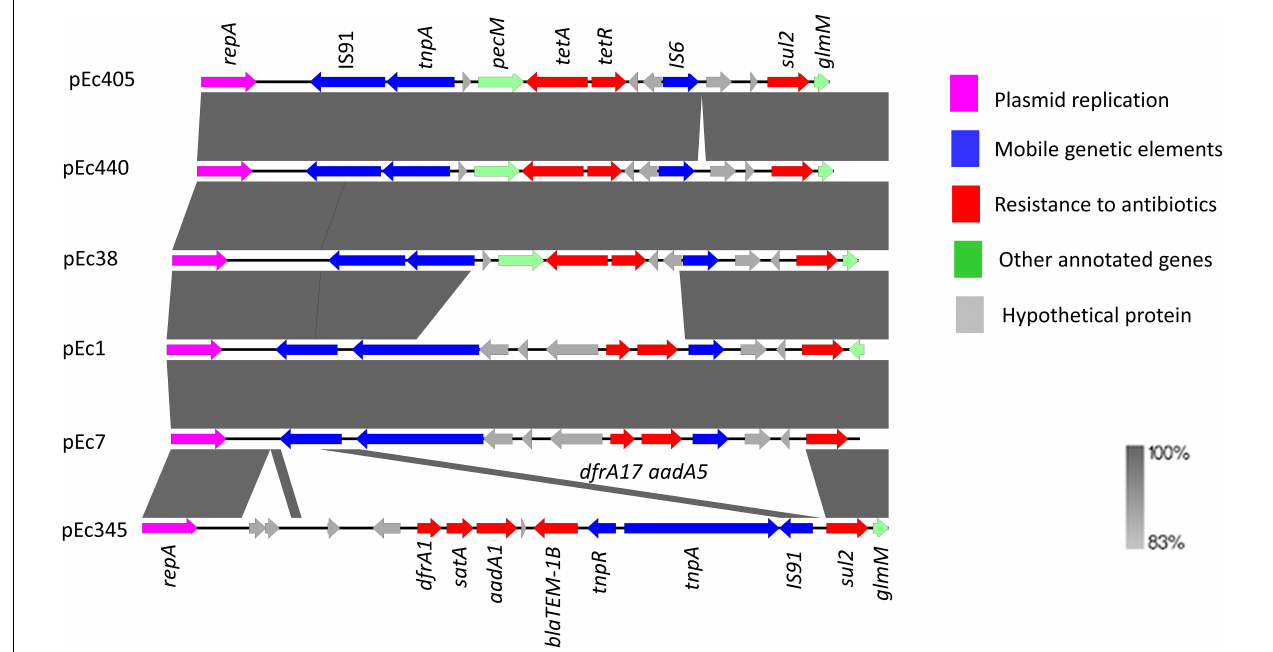
FIGURE 3 | Syntenic analysis of 6 IncI1-I γ /ST3 plasmids from six Escherichia coli isolates collected in Guadeloupe. All isolates produced an extended-spectrum β -lactamase ( bla CTX − M − 1 ) except for pEC345. The innermost black ring 1 represents the reference sequence of pEC405. The subsequent rings correspond to pairwise comparisons with pEC405: ring 2 represents pEC440; ring 3, pEC38; ring 4, pEC1; ring 5, pEc7; ring 6, pEC345. The last two rings represent a genetic map of